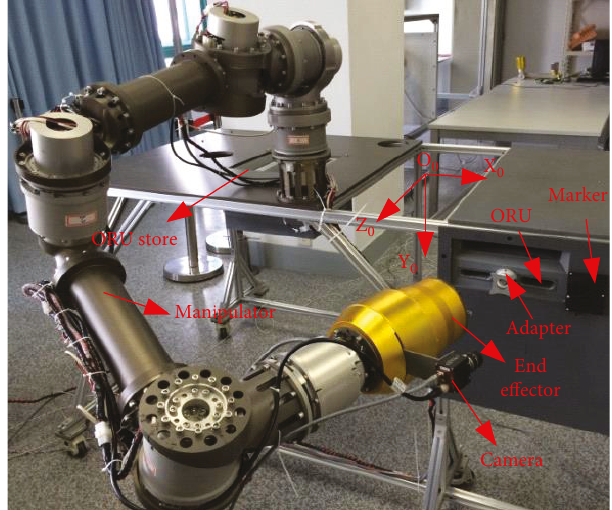
Figure 2: Ground experiment platform for ORU